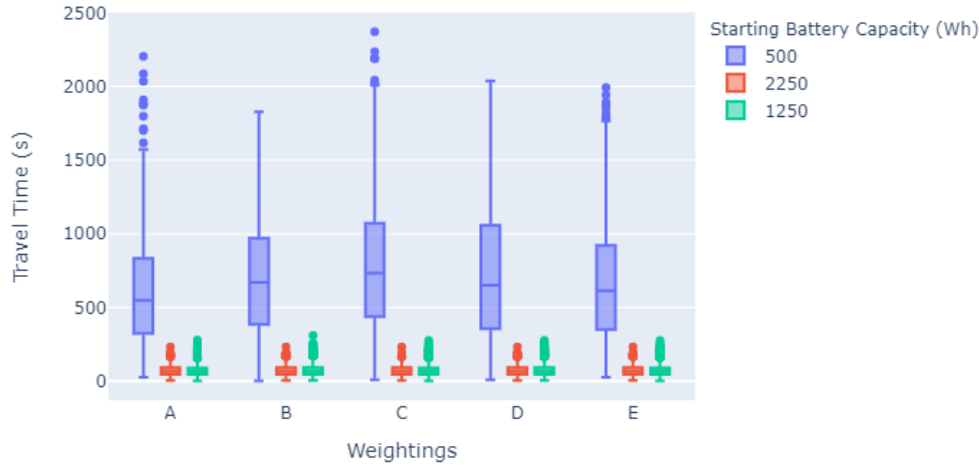
Figure 5. The achieved travel time under varying the weightings: the case of the grid road